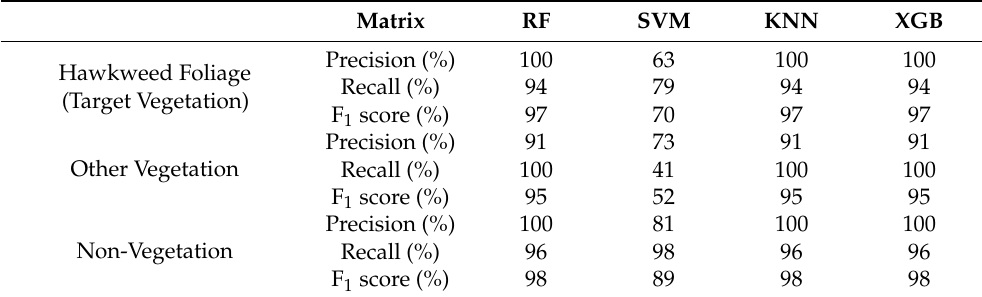
Table 10. Classification report (testing) of different machine learning models for detection of hawk- weed foliage at 0.65 cm/pixel. Matrix RF SVM KNN XGB Precision (%) Hawkweed Foliage